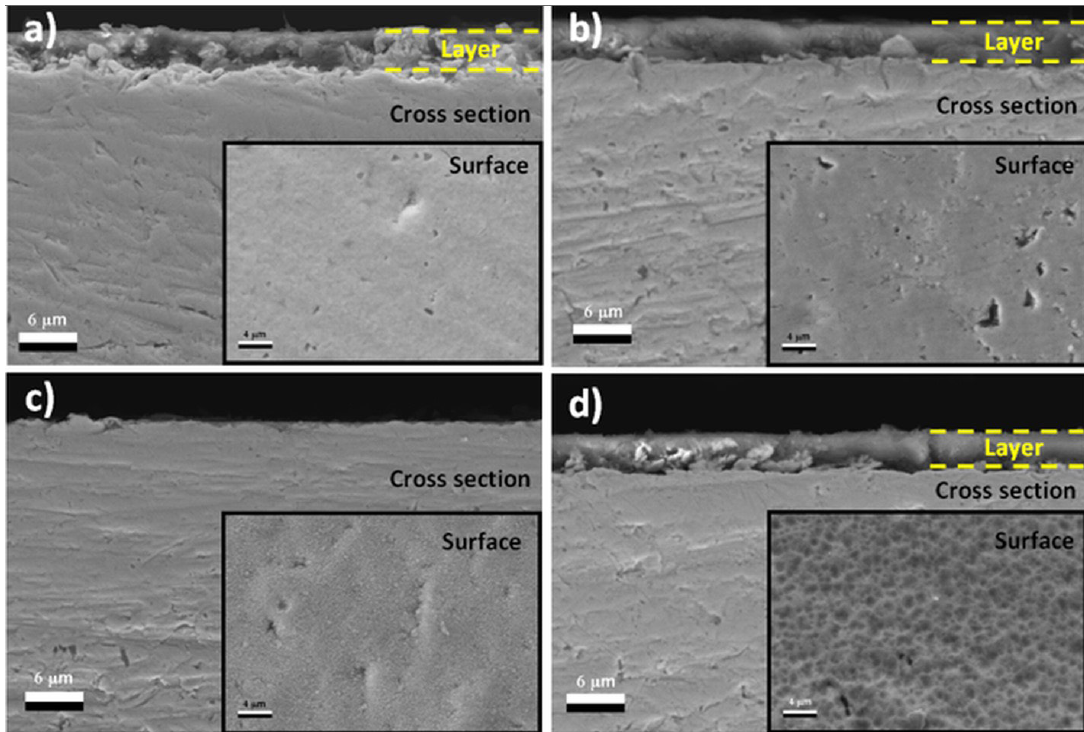
Figure 3. Micrographs obtained by SEM of niobium samples nitrided conventionally and in the cathodic cage. a), b), c), and d), respectively, PN400, PN450, CCPD400, and